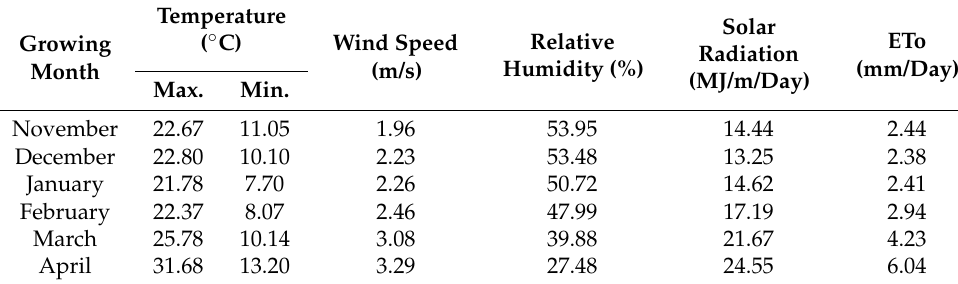
Table 1. The mean values of meteorological parameters at Sids